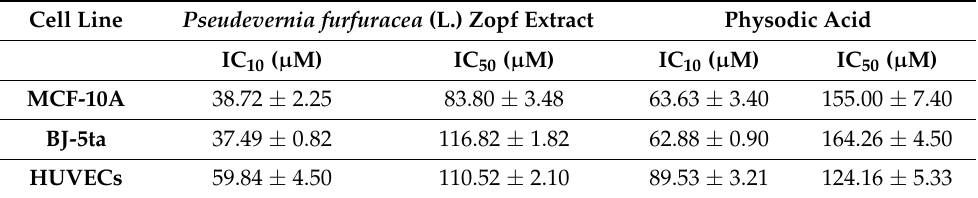
Figure 4. Effect of PSE and Phy on MCF-10A, BJ-5ta and HUVECs BrdU (5-bromo-2'-deoxyuridine) incorporation. MCF- 10A ( A ) and BJ-5ta ( B ) cells were treated with various concentrations of PSE and Phy (10–100 µ g/mol) for 72 h. HUVECs were treated with the same range of concentrations of tested compounds in the absence ( C ) or presence ( D ) of VEGF (25 ng/mL) for 48 h. Values represent the mean ± standard deviation. (* p < 0.05, ** p < 0.01, *** p < 0.001 compared to control; # p < 0.05, ## p < 0.01 compared to VEGF). Table 4. IC 10 and IC 50 values of PSE and Phy for MCF-10A, BJ-5ta and HUVEC